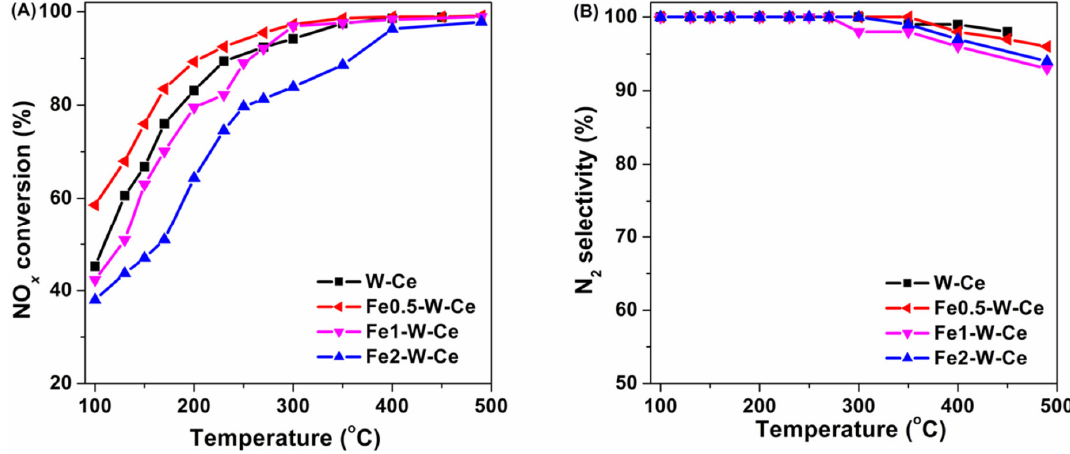
Figure 1. ( A ) NO x conversion; and ( B ) N 2 selectivity of Fe-W-Ce catalysts. Reaction conditions: [NO x ] = 450 ppm, [NH 3 ] = 450 ppm, 2.5% O 2 , N 2 as balance, GHSV = 20,000 h − 1 .